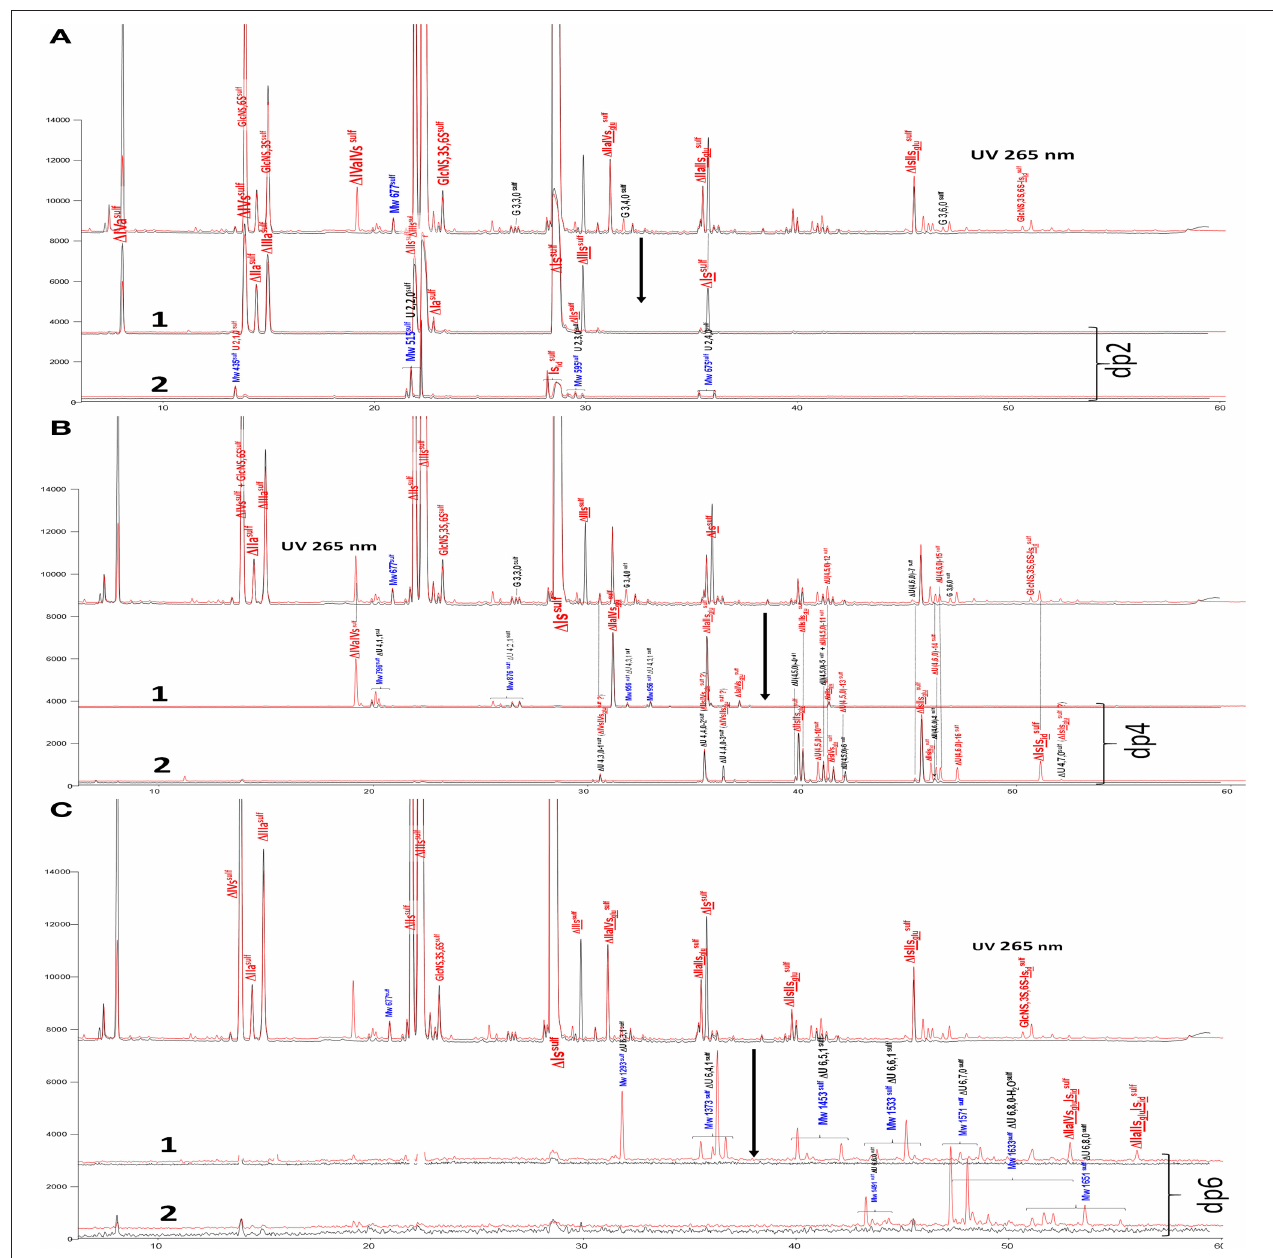
FIGURE 3 | (A) Comparison by liquid chromatography/mass spectrometry ion pair chromatography of heparinase I + II + III ( — ) and heparinase II ( — ) digests of bovine mucosal heparin after sulfanilic reductive amination. Reconstructed ion pair chromatograms (RIC) of disaccharide (dp2 are compared to UV chromatograms detected at 265nm. ( 1 ) RIC unsaturated disaccharides: m/z 535.14 + 573.07 + 615.094_615.2 + 652.906 _653.05 + 695 + 848.1 + 1043.2; ( 2 ) RIC non-reducing end disaccharides: m/z 591.1 + 671.1 + 866.2 + 1061.3 (Correspondence of m/z values is specified in Supplementary Table 3 ). (B) Comparison by liquid chromatography/mass spectrometry ion pair chromatography of heparinase I + II + III ( — ) and heparinase II ( — ) digests of bovine mucosal heparin after sulfanilic reductive amination. Reconstructed ion pair chromatograms (RIC) of tetrasaccharide (dp4) are compared to UV chromatograms detected at 265nm. ( 1 ) RIC acetylated tetrasaccharides: m/z 555.6 + 595.6 + 635.5 + 515.6 + 952.2; ( 2 ) RIC sulfated tetrasaccharides: m/z 614.5 + 712 (Correspondence of m/z values is specified in Supplementary Table 3 ). (C) Comparison by liquid chromatography/mass spectrometry ion pair chromatography of heparinase I + II + III ( — ) and heparinase II ( — ) digests of bovine mucosal heparin after sulfanilic reductive amination. Reconstructed ion pair chromatograms (RIC) of ( 1 ) RIC acetylated hexasaccharides: m/z 724.156_724.3 + 764.1 + 861.7 + 959.2 + 1056.8 + 1154.3; ( 2 ) RIC sulfated hexasaccharides: m/z 880.6 + 978.2 + 1133.3 (Correspondence of m/z values is specified in Supplementary Table 3